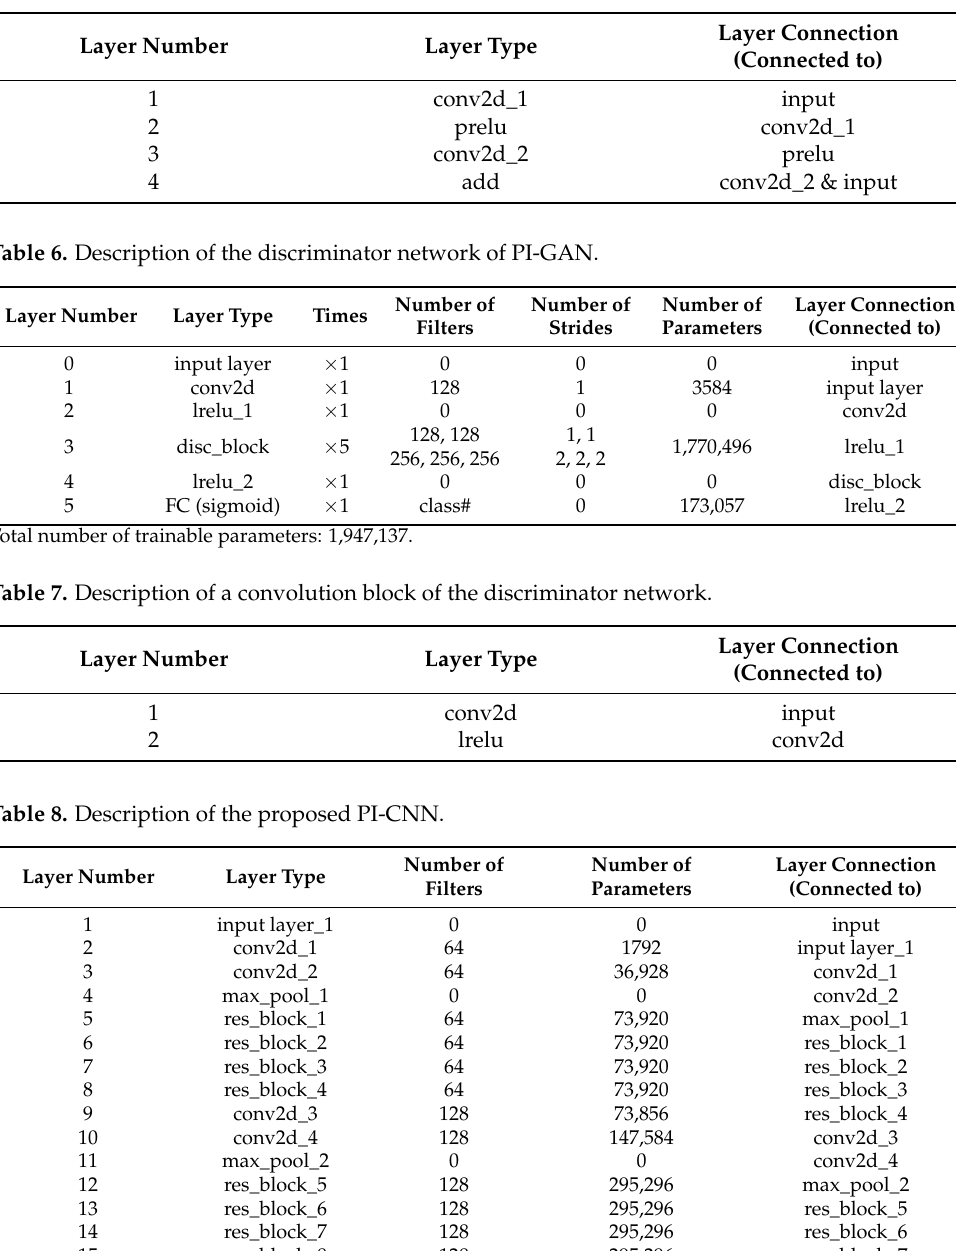
Table 5. Description of a residual block of the generator network.